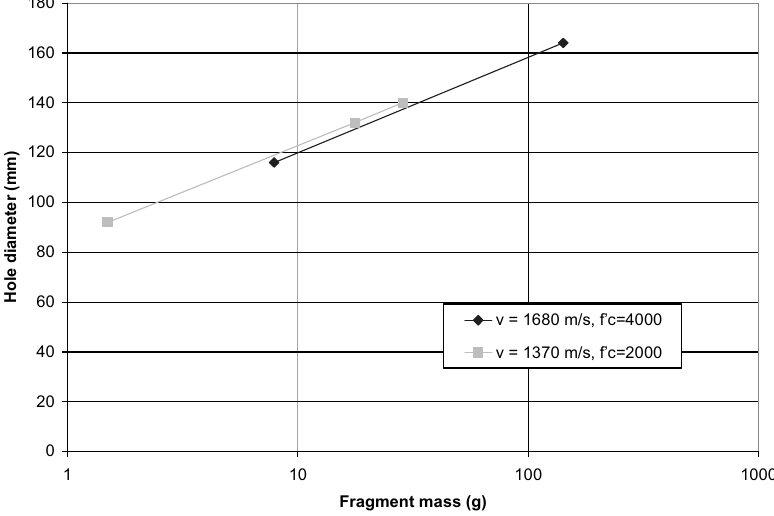
Fig. 9. Hole diameter as a function of fragment mass from AUTODYN calculations.